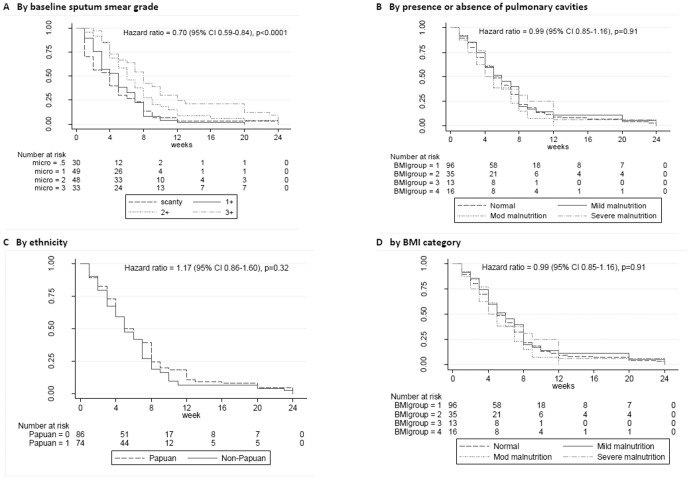
Kaplan-Meier survival curve showing probability of sputum smear conversion.A. by baseline sputum smear grade. B. by presence or absence of pulmonary cavities. C. by ethnicity. D. by BMI category.